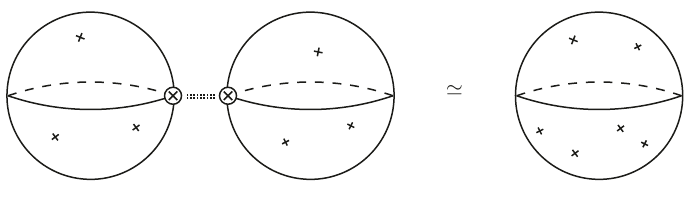
Figure 1 . Gluing two genus zero correlators, forming a new